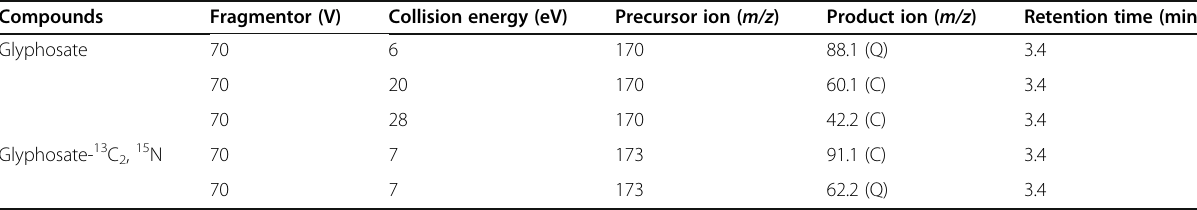
Table 2 Compound-specific mass spectrometer settings